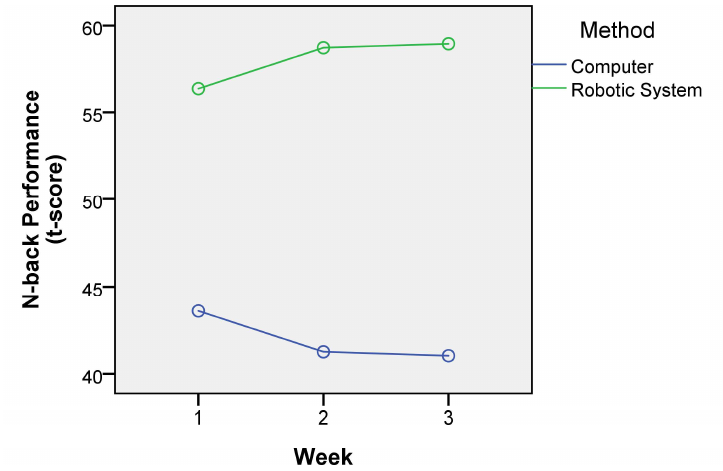
Figure 6. Mean WM performance across three